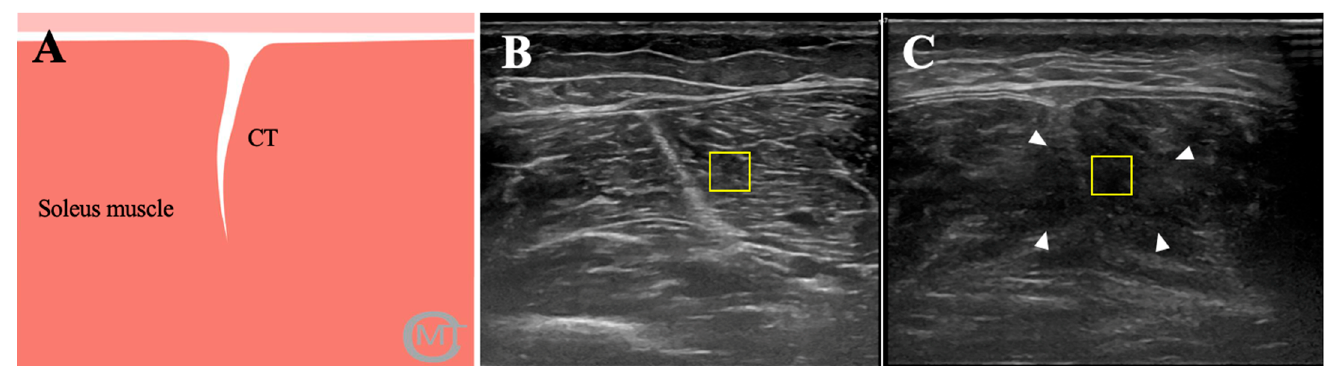
Figure 1. Ultrasound images of central tendon of soleus muscle. ( A ). Graphic representation of the ultrasound image of the soleus muscle; ( B ). Ultrasound imaging of health athlete; ( C ). Ultrasound imaging of an athlete with soleus muscle injury. Ultrasound imaging of patients group shows muscle fiber disorganization at the level of tear (arrowhead). CT, central tendon; ROI.